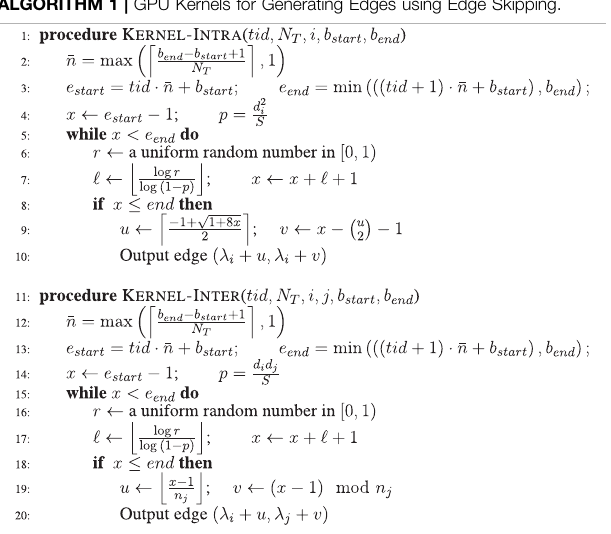
ALGORITHM 1 | GPU Kernels for Generating Edges using Edge Skipping.